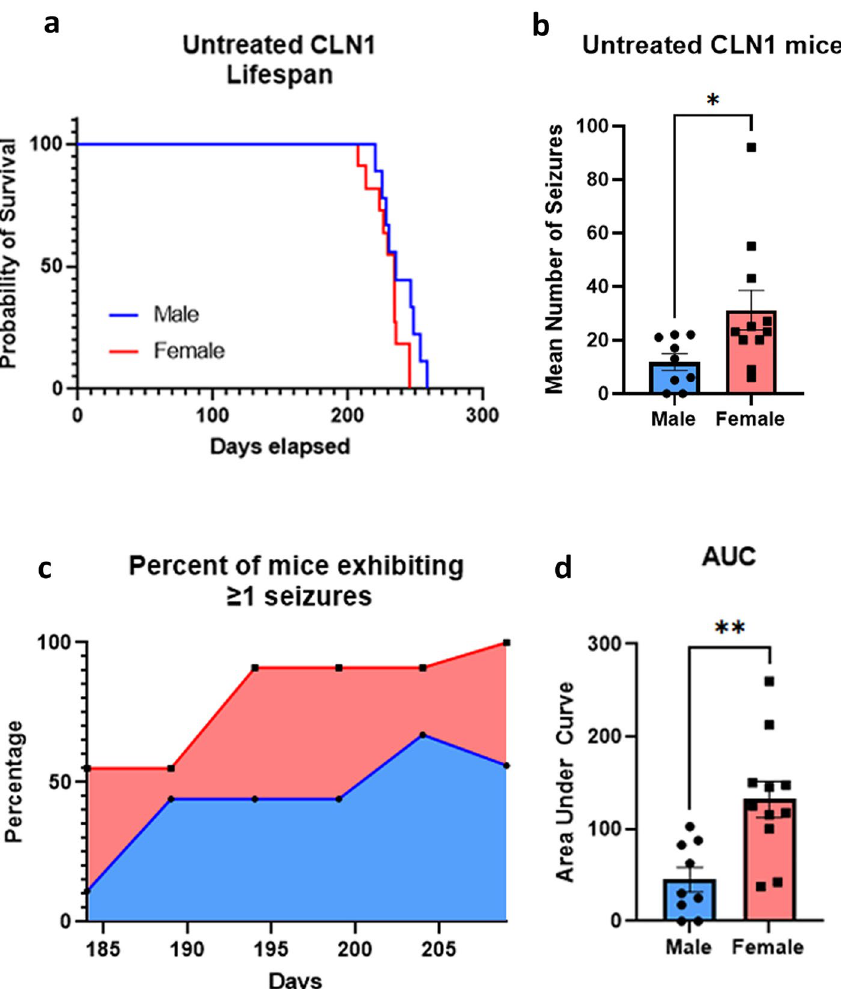
Figure 4. Female Cln1 −/− mice exhibit more, and earlier, seizures, compared to males. ( a ) While the four longest-lived mice were all male, there was no difference in life span between untreated, EEG-monitored males (n = 9) and females (n = 11). ( b ) Females exhibited more total seizures, over the period when all animals remained alive, compared to males, and they appeared to have an earlier onset. ( c , d ) A higher percentage of female mice exhibited at least 1 seizure earlier compared to males, and more females exhibited seizures across this timeframe than males as measured by area under the curve. Data shown are means ± SEM. *Indicates p = 0.038; **indicates p <